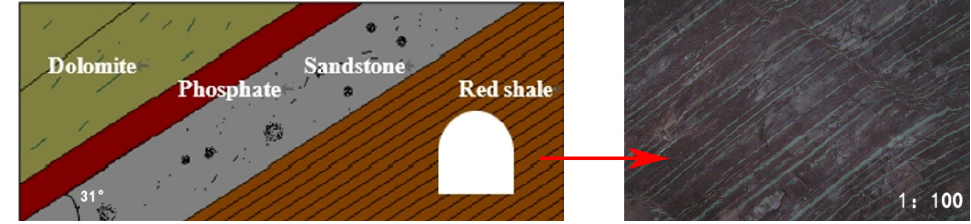
Figure 1. The red shale inclined bedding structure around roadway cross section. Table 1. The main mineral composition and its content of red shale.